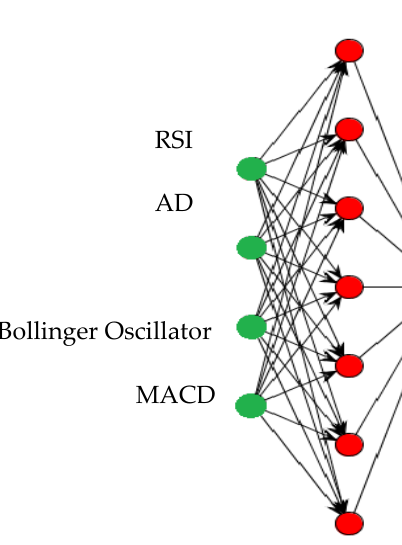
Figure 2. Example of multilayer perceptron (MLP) network featuring 4 inputs, 7 neurons in the hidden layer and a single output. RSI = Relative strength index, AD = Accumulation/distribution, MACD = Moving average convergence/divergence.